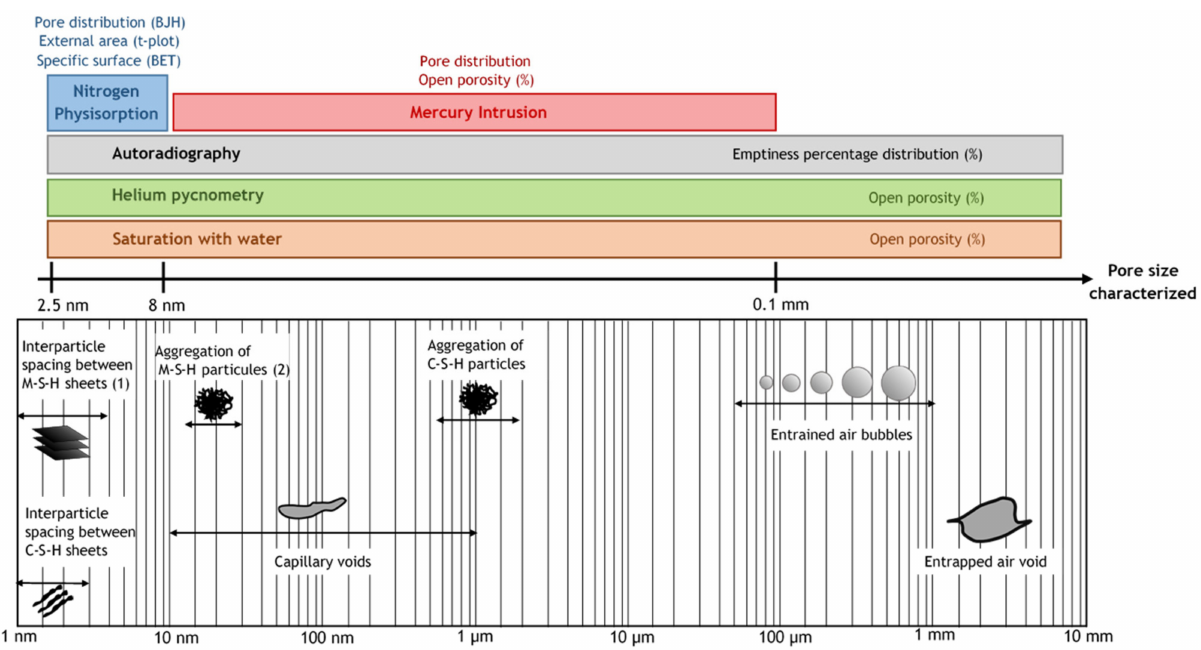
Figure 1. Representation of porosity characterization techniques as a function of pore range associ- ated with the dimensional range of solids and pores in an M-S-H paste (adapted from Mehta and Monteiro [53]). (1) After Bernard [43] and (2) after Tonelli [46]. M-S-H samples were analyzed by X-ray microtomography using two different devices: SkyScan 1272 and SkyScan 1173 (Bruker microCT N.V, Fontenay-aux-Roses, France). A spatial resolution of 15 µ m was obtained for a sample size of approximately 5 cm 3 . The parameters of the X-ray tube (100 kV, 100 mA) were set to optimize the contrast between the different phases and the pores. An angular step of 0.3 ◦ was used to acquire radiographs (total acquisition time of approximately 9